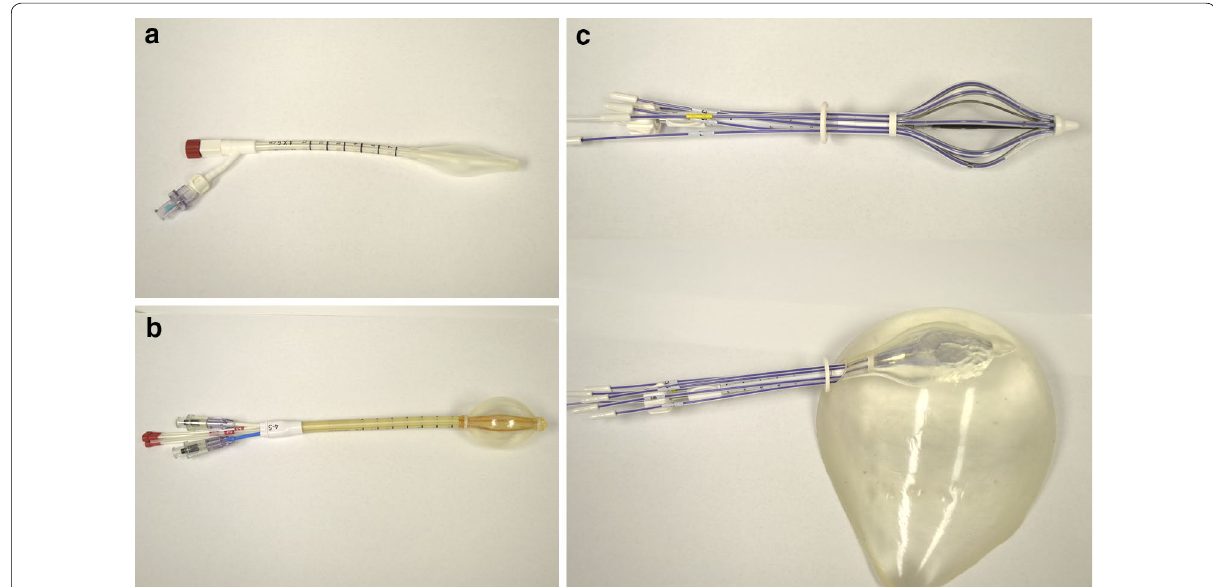
Fig. 1 Single- and multi-lumen/multi-catheter applicators used in accelerated partial breast irradiation. a An inflated 4X6 MammoSite ® (Hologic, Bedford, MA, USA) balloon. b An inflated 4–5 Contura ® (SenoRx, Inc., Aliso Viejo, CA, USA) balloon. c An expanded SAVI ® (Cianna Medical, Aliso Viejo, CA, USA) 8–1 balloon ( top ) and placed in plastic model ( bottom